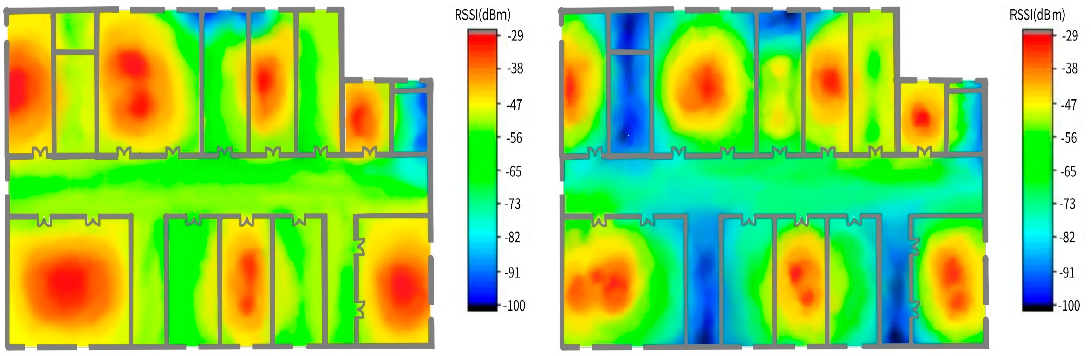
Figure 9. Experimental floor layout.